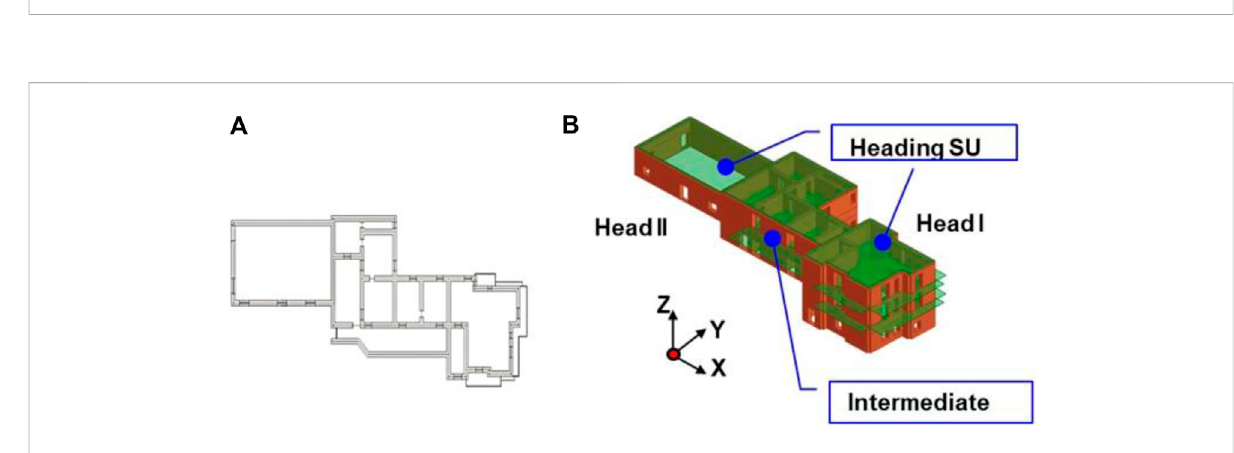
common between two structural units, the shear is divided in two equal parts between them. The worst pushover curves in the two main analysis directions derived from performed analysis on the three SUs are depicted in Figure